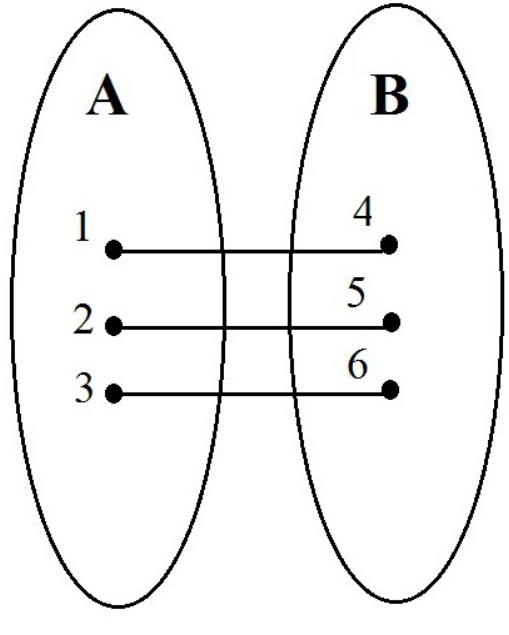
Figure 12. Each vertex is at any